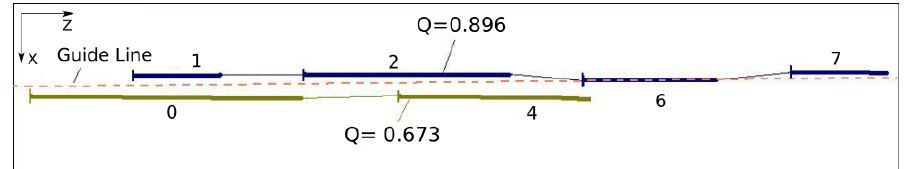
Figure 15. The two best reconstructions corresponding to the example of Figure